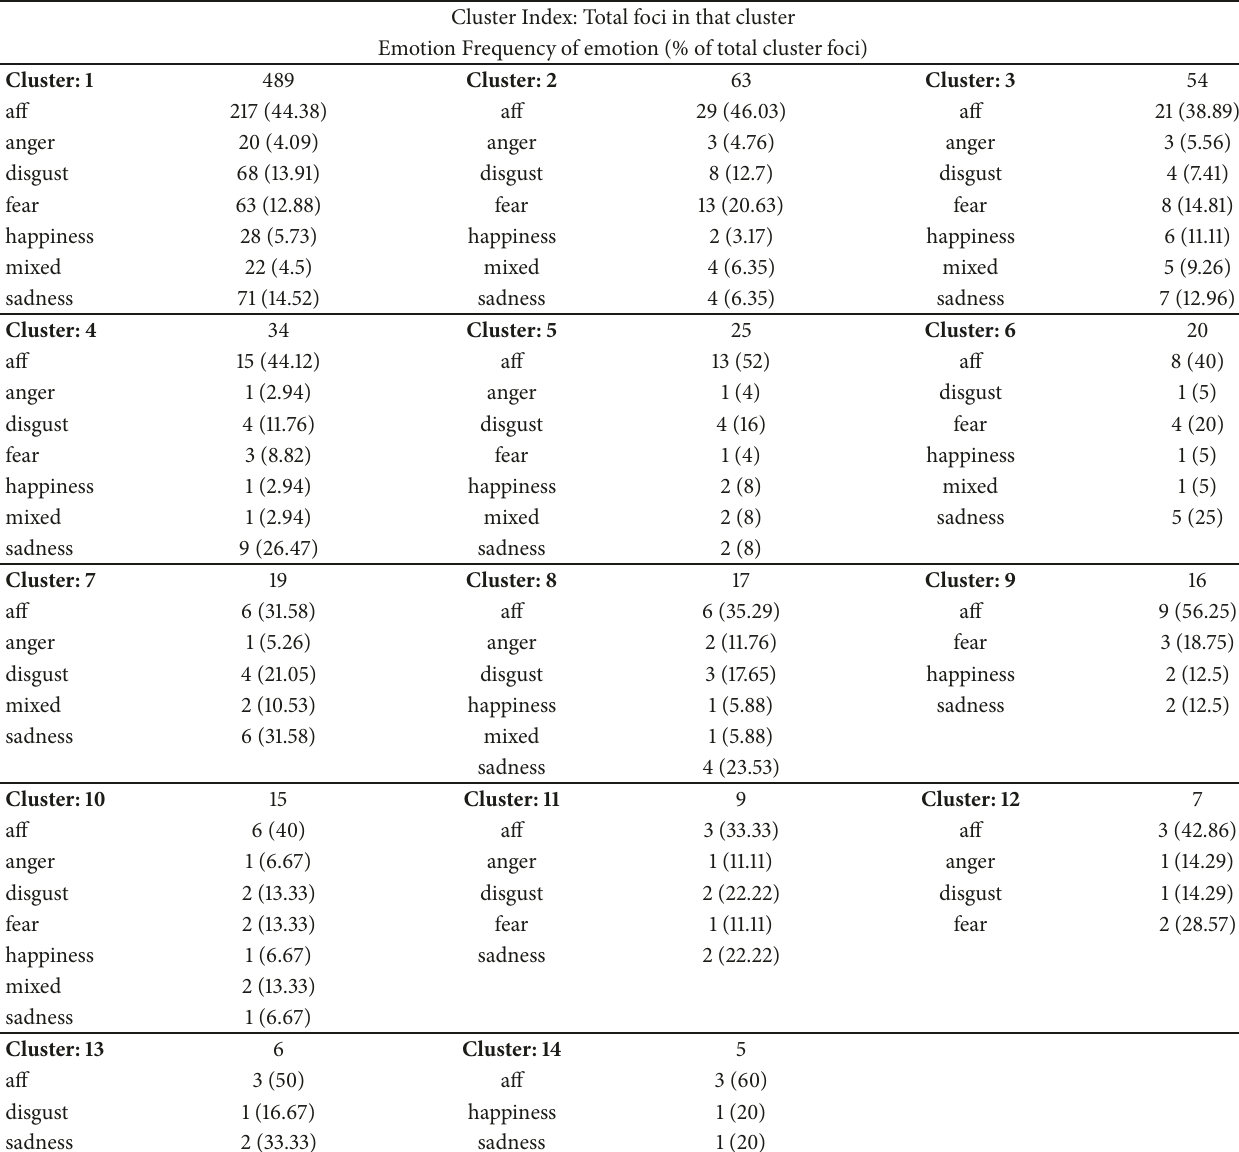
Table 8: Breakdown of emotions and their frequencies by individual foci cluster for ROI ∗ . Cluster Index: Total foci in that